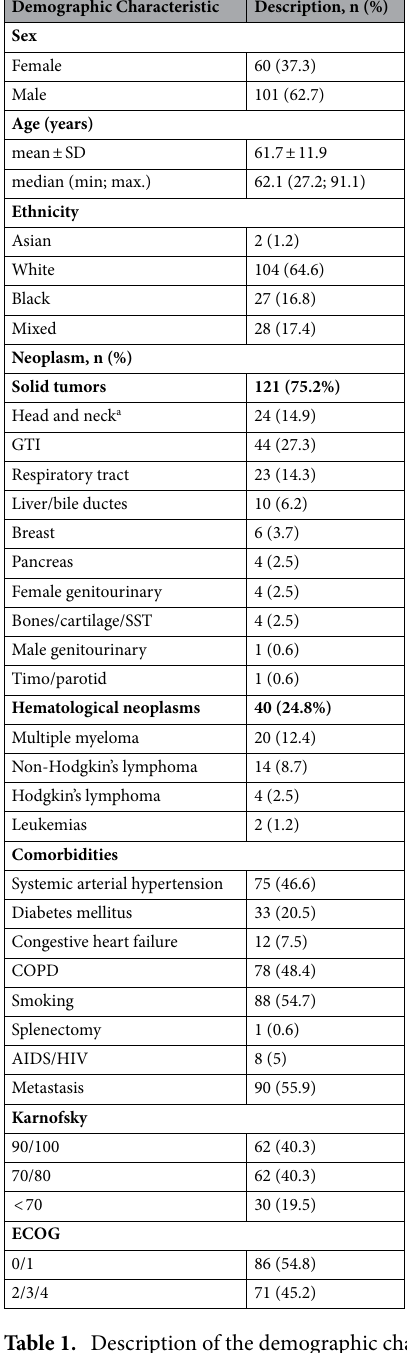
Table 1. Description of the demographic characteristics evaluated in 161 cancer patients with Streptococcus pneumoniae bacteremia in cancer patients. GTI gastrointestinal tract (esophagus, stomach, small intestine, colon, anus and rectum), SST skin and soft tissue, COPD chronic obstructive pulmonary disease. a Head and neck, means oral cavity, larynx and